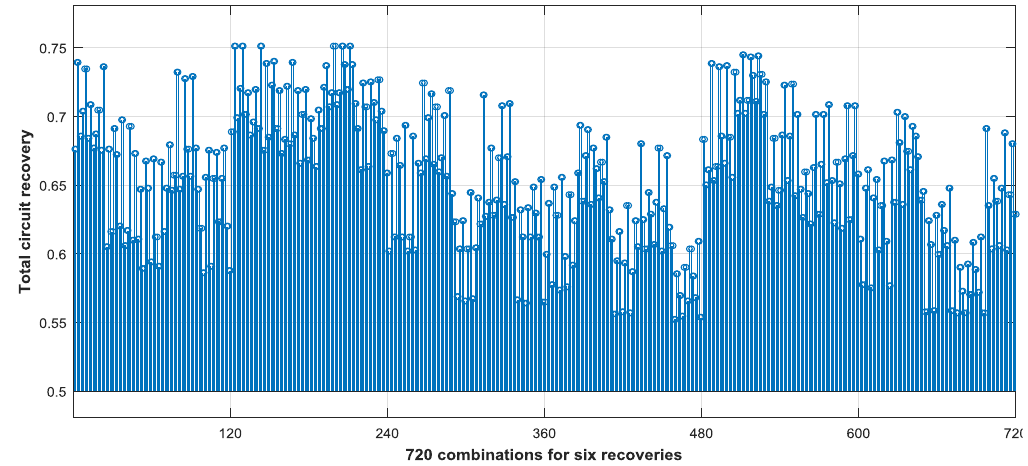
Figure 8. Overall circuit recovery for 720 possible combinations of stage recoveries.